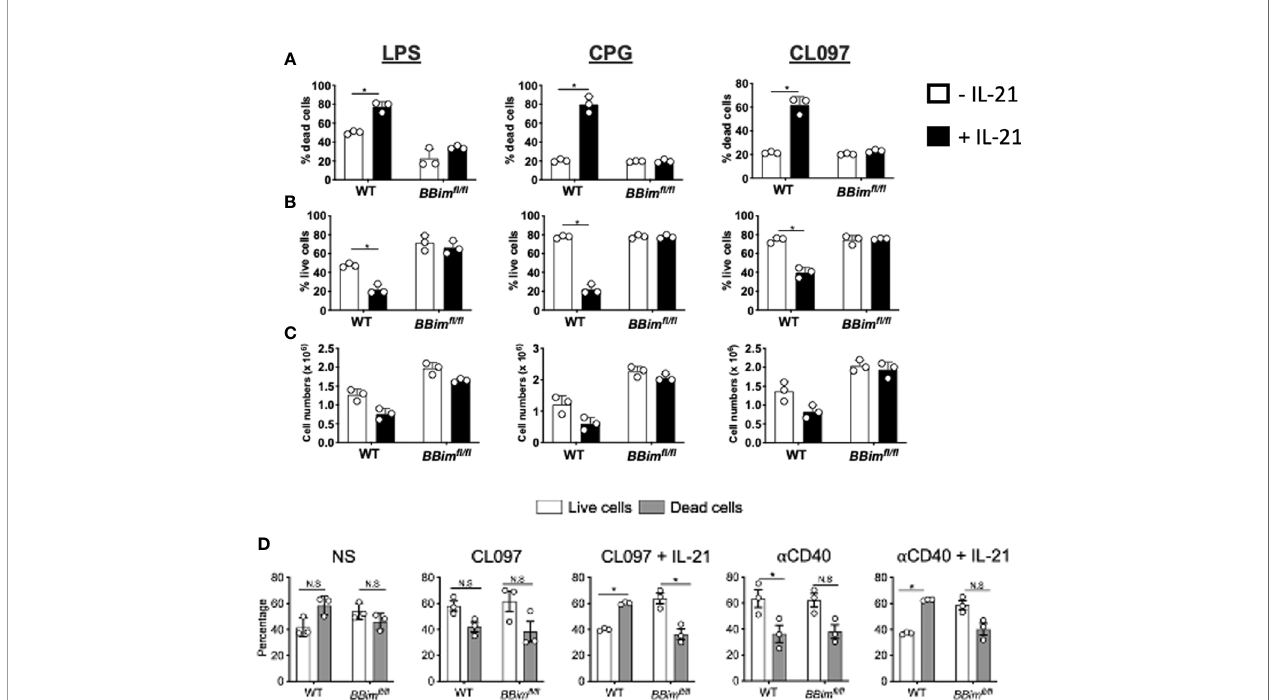
FIGURE 7 | BBim fl / fl B cells are resistant apoptosis costimulated with IL-21 and via TLR4, TLR7, TLR9 or CD40. Puri fi ed B cells from WT and BBim fl / fl mice were incubated for 48 hours with the indicated TLR agonists or anti-CD40 in the absence or in the presence of IL-21 (25ng/ml) and then analyzed for (A) dead cells and (B) live cells distinguished using a fi xable viability dye (Invitrogen). (C) Numbers of live B cells in the cultures (trypan blue-) (D) Splenocytes from BBim fl / fl and WT mice were treated with TLR7 agonist (CL097) or anti-CD40 Abs in the absence or in the presence of IL-21 (25ng/ml), stained with annexin V and 7AAD and analyzed by FCM. Bar graphs showing percentages of B cells that are live (white; 7AAD- Annexin V-) and dead (gray; 7AAD+/- Annexin V+) after culture for 48 hours. Not signi fi cant (N.S) P > 0.05, *P ≤ 0.05, calculated by Students